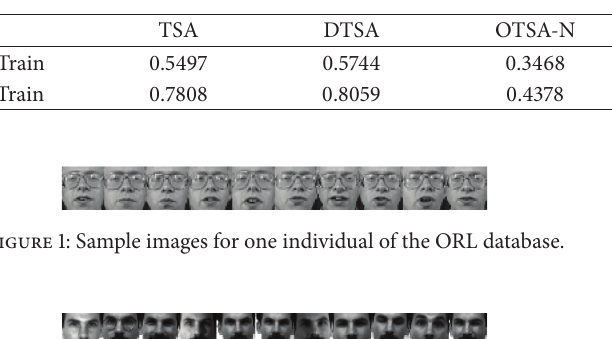
Figure 2: Sample images for one individual of the Yale